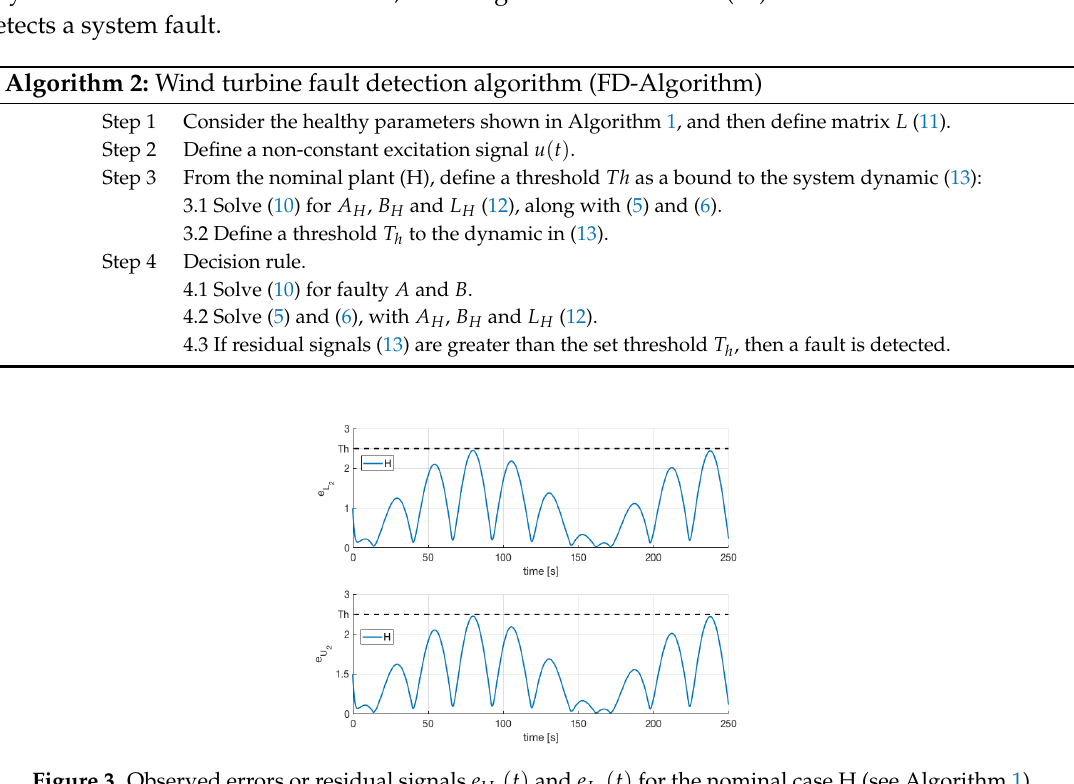
Figure 3. Observed errors or residual signals e U We can state T h = 2.5 as a bound for the residual signals (dashed). Note that both errors are identical because no fault is